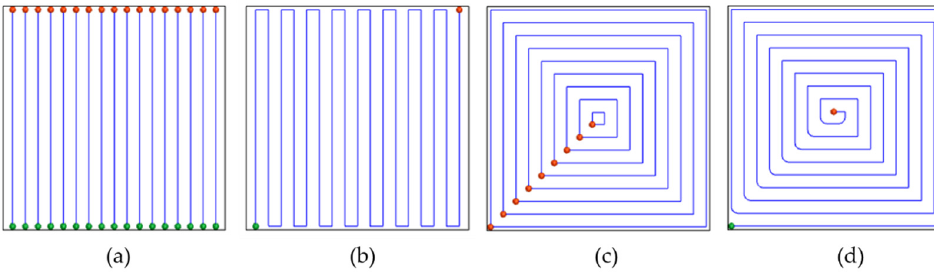
Figure 3. Schematic of different build-up patterns: ( a ) raster, ( b ) zigzag, ( c ) contour and ( d ) spiral. Ding et al. presented in [11] a method for a gap free path pattern generation based on medial axis transformation (MAT). This technique was first proposed by Blum [12]. For generating the media axis of a shape, circles with the largest possible radius are inserted in the shape to be filled. As depicted in Figure 4, the centres of all circles build the medial axis, which is basically the line for the parallel filling of the layer. Figure 4. Schematic for the generation of the medial axis, by [11]. However, the path to be applied strongly depends on the part that has to be manu- factured and, of course, on the manufacturing system and the path planning software. For each welding set-up, process parameter set, material, and path planning software, another filling-strategy may apply. Coming back to the design process, often the geometry does not meet the necessary requirements to be considered directly ready for production. In this case, the geometry has to be manually changed. Some software solutions for path planning are already available with the ability to adapt the geometry through the con- straints of the fabrications process. With the creation of a printable path, the generation of the geometry is usually completed. With regard to the high degree of automation in other industries, the manual adaption of the geometry to manufacturing possibilities for struc- tural components also needs to be automated. In this paper, a design method for DED-arc components is presented, which takes manufacturing possibilities into account. It is based on self-organizing systems. For this, an initial geometry was generated as a solid part, then it was force-flow optimized. The originated geometric features were transformed into a small-scale case study demonstra- tor. For this representative geometry, the path planning was conducted and the robot path was generated. Afterwards, the manufacturing restraints of a Kuka 6-Axis robot manu- facturing system were identified for a certain parameter set, applying 3-axis manufactur- ing. The restraints identified were given back to the design process and were considered in the generation of the geometry of a steel node.